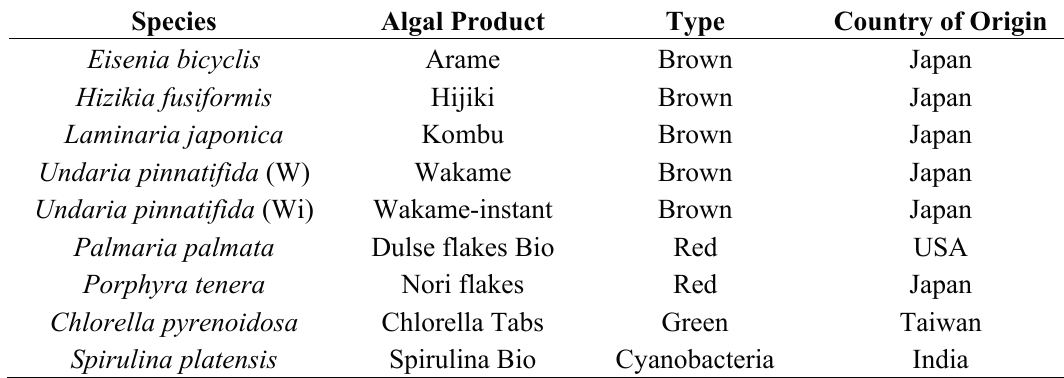
Table 3. Edible algal products